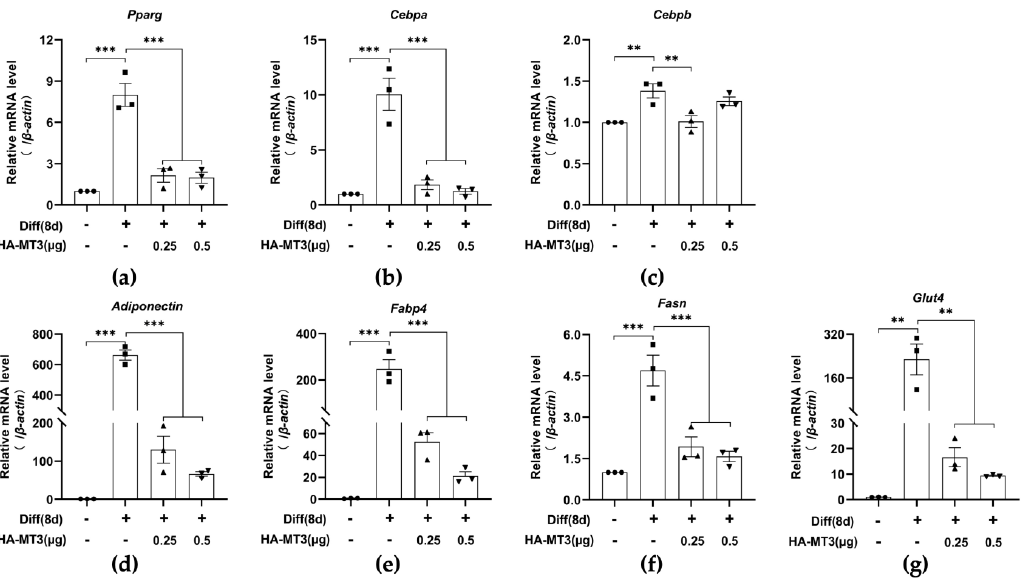
Figure 5. Mt3 overexpression reduces adipogenesis-related gene expression in 3T3 − L1 cells. 3T3 − L1 cells were transfected with HA − MT3 plasmid (0.25, 0.5 µ g) prior to contact inhibition and induced adipocyte differentiation using differentiation cocktail. ( a – g ) The mRNA levels of Mt3 , Pparg , Cebpa , Cebpb , Adiponectin , Fabp4 , Fasn, and Glut4 in the different groups were compared by RT-qPCR. β -